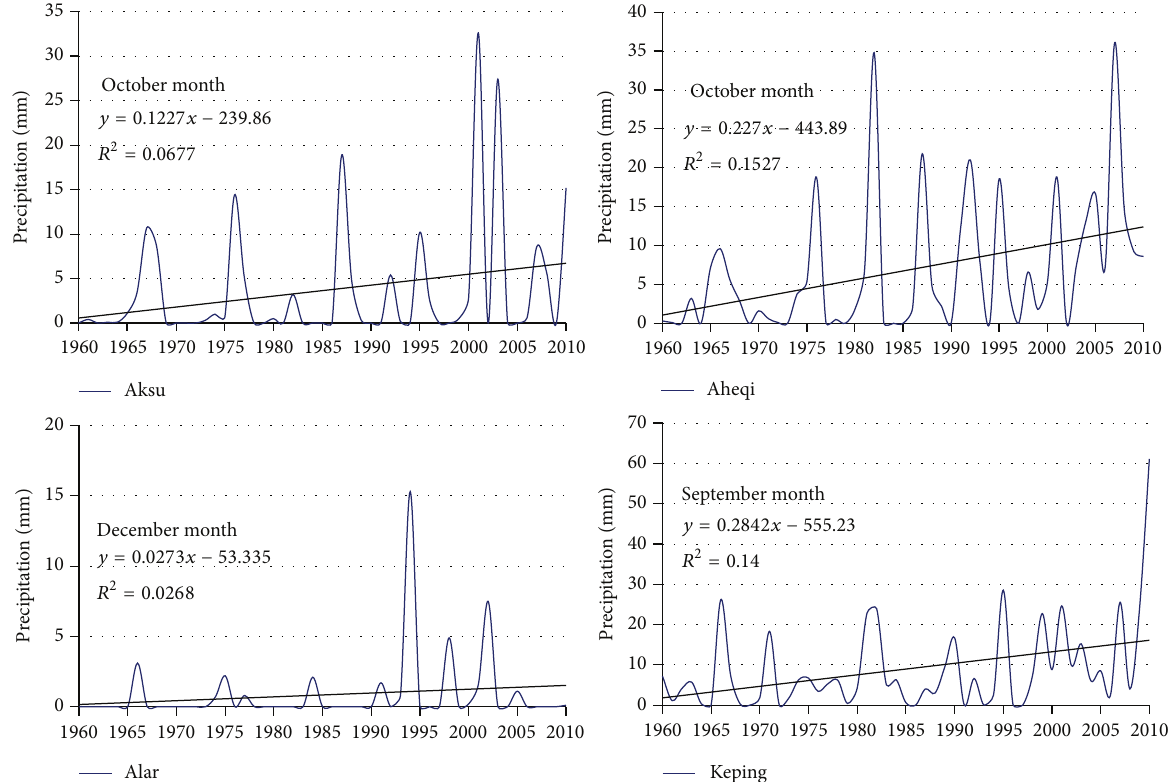
Figure 6: Variations of monthly precipitation in stations with the significant trends during the study